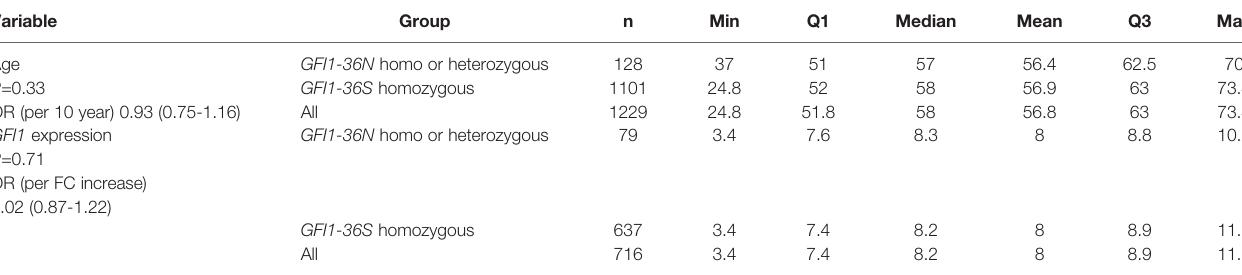
TABLE 3 | Correlation between presence of GFI1-36N allele and age or GFI1-RNA expression level. Variable